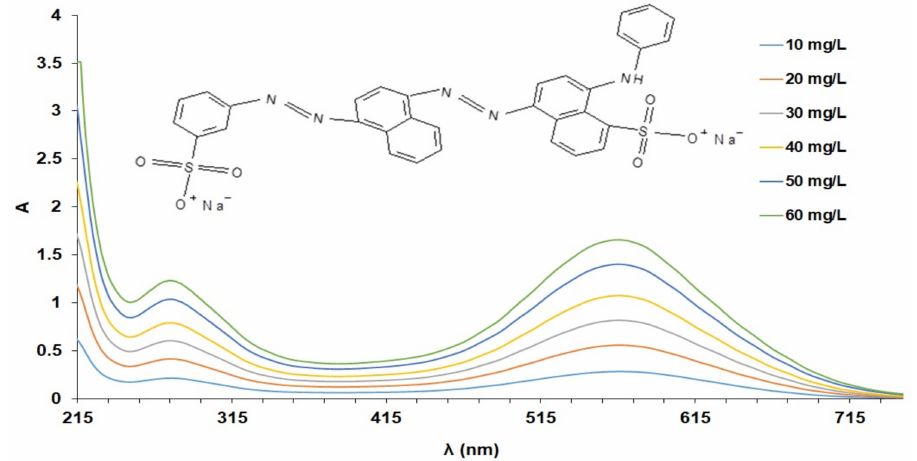
Figure 1. Representation of A = f ( λ ) for 10, 20, 30, 40, 50 and 60 mg/L solutions of AB